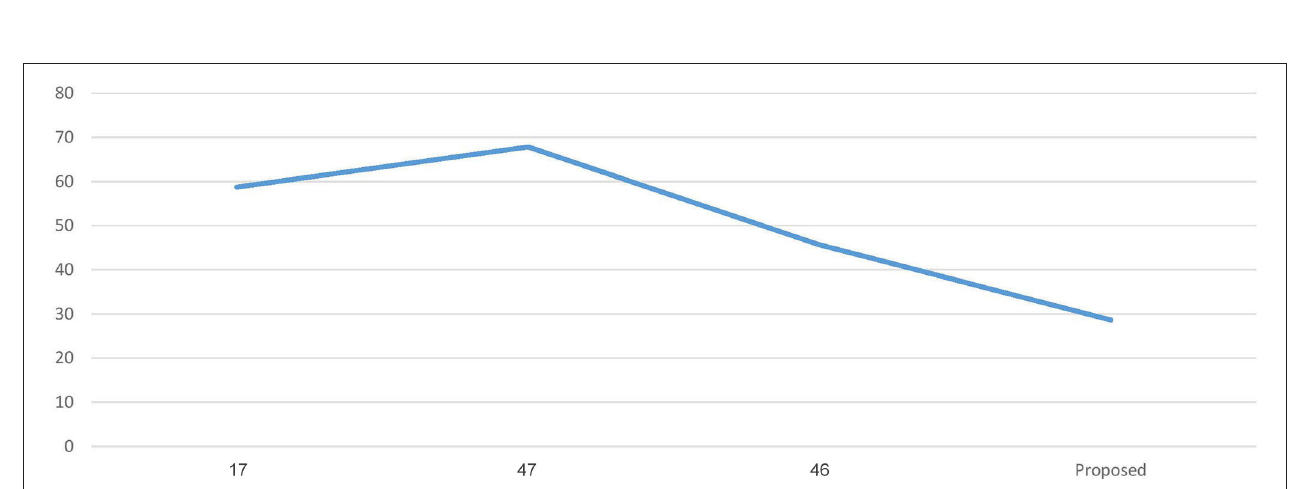
FIGURE 5 | Comparison of prediction accuracy.